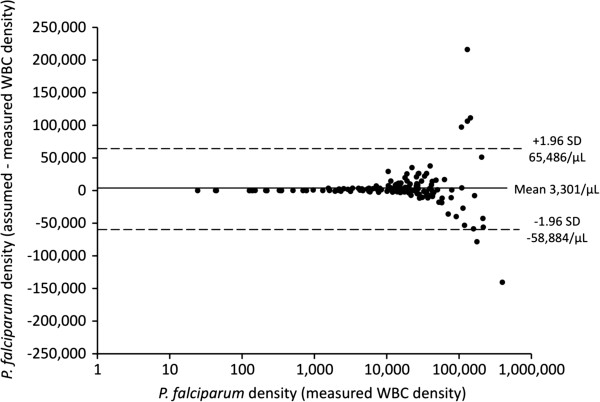
Bland Altman plot showing parasite densities estimated using measured white blood cell densities on a logarithmic scale for Plasmodium falciparum cases (abscissa) and the difference in parasite density from assumed and measured leucocyte densities (ordinate axis). The mean difference (solid line) and 95% limits of agreement (dashed lines) are also shown.